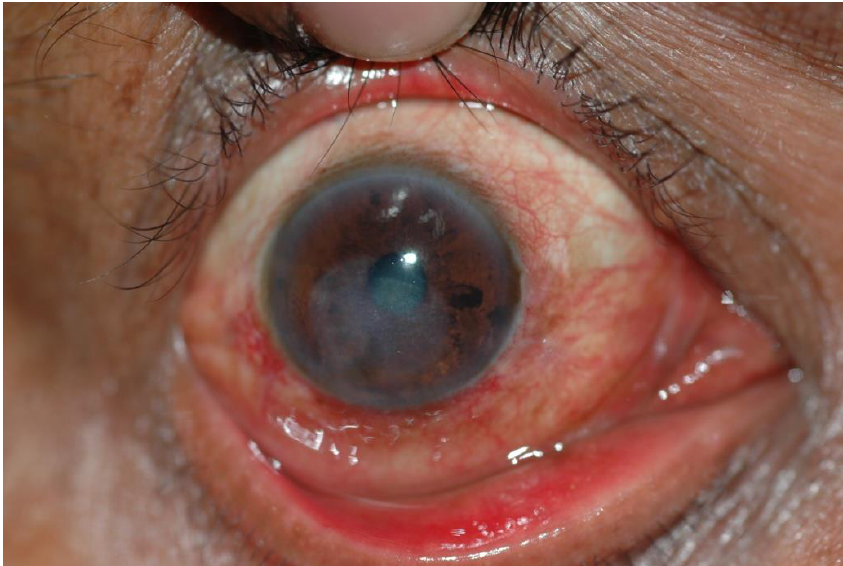
Figure 3. Corneal ulcer caused by Fusarium spp. at 3 months. Source: Mycotic Ulcer Treatment Trial, Aravind Eye Hospital, Tamil Nadu, India.